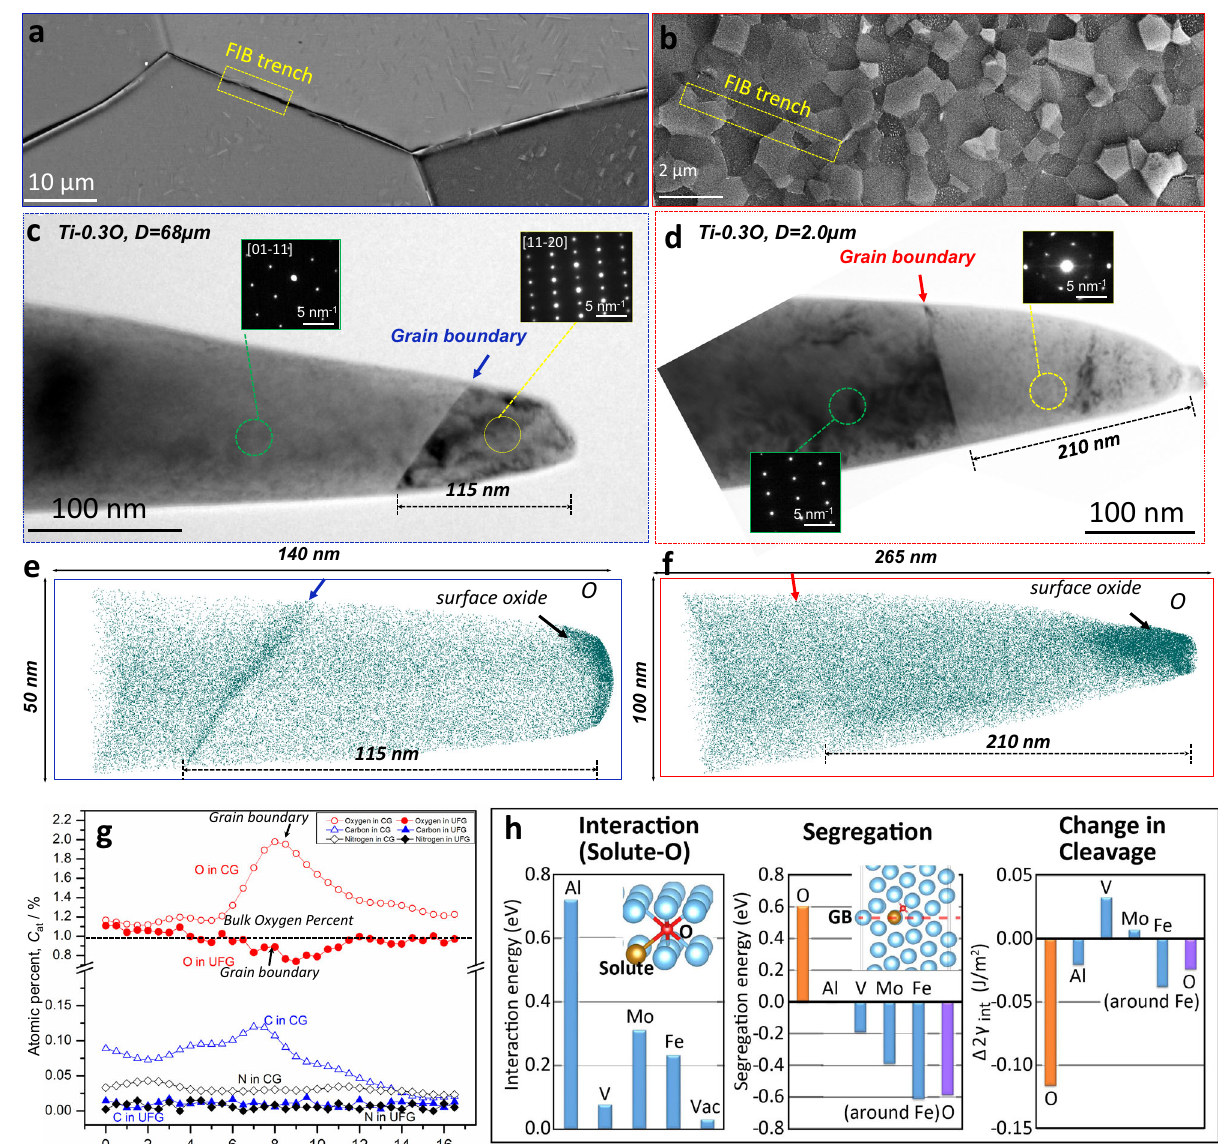
Fig. 5 | GB chemistry analysis of CG and UFG Ti-0.3O. BSE images of CG ( D =68 µ m) a and UFG ( D =2.0 µ m) b Ti-0.3O. Schematic illustrations of the grain boundary lift-out positions for APT specimens are indicated in both micro- structures. Transmission electron microscopy (TEM) images of APT